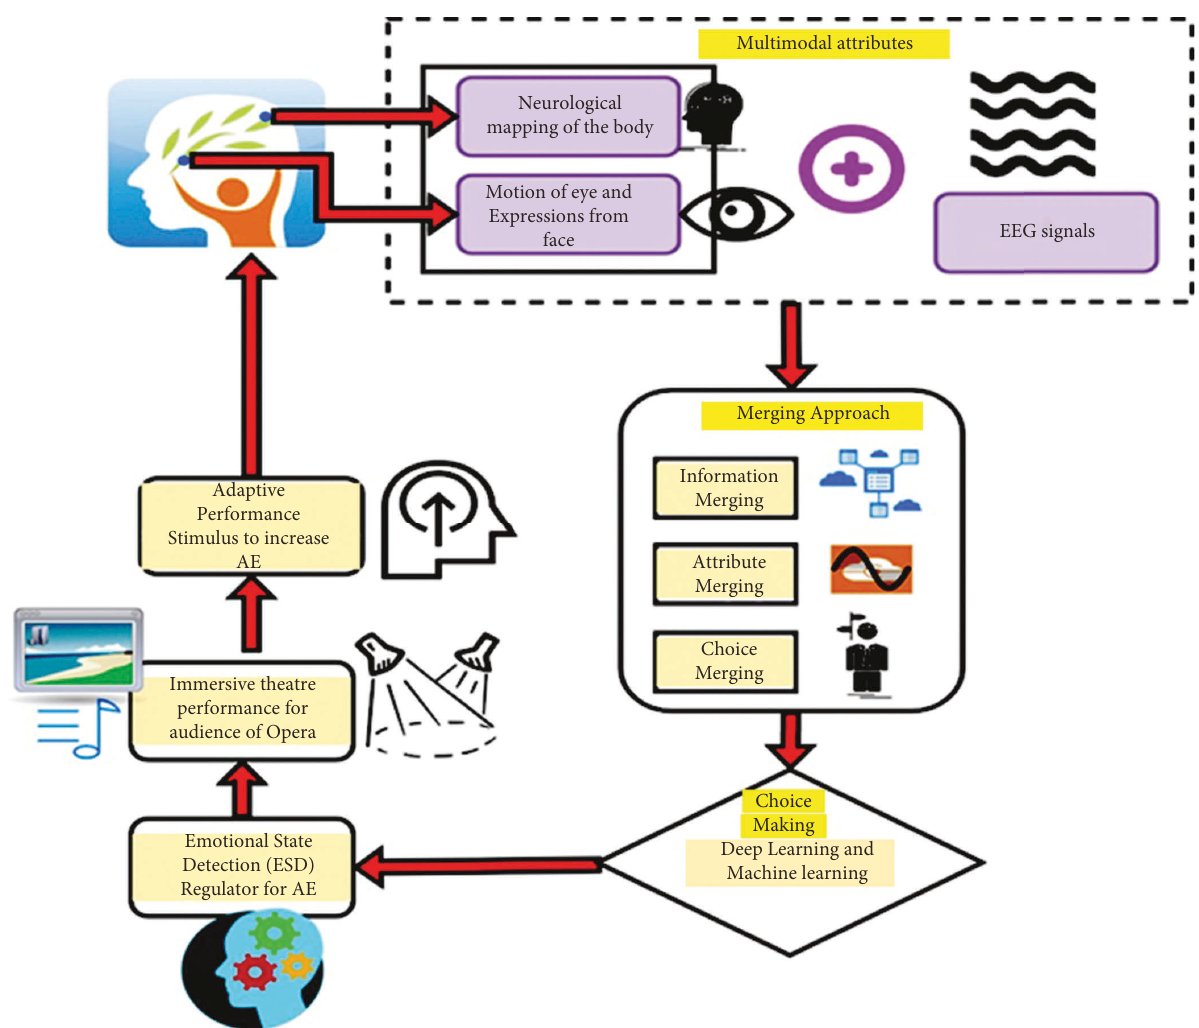
Figure 1: Movement of information in the proposed MESDT using BCI for opera